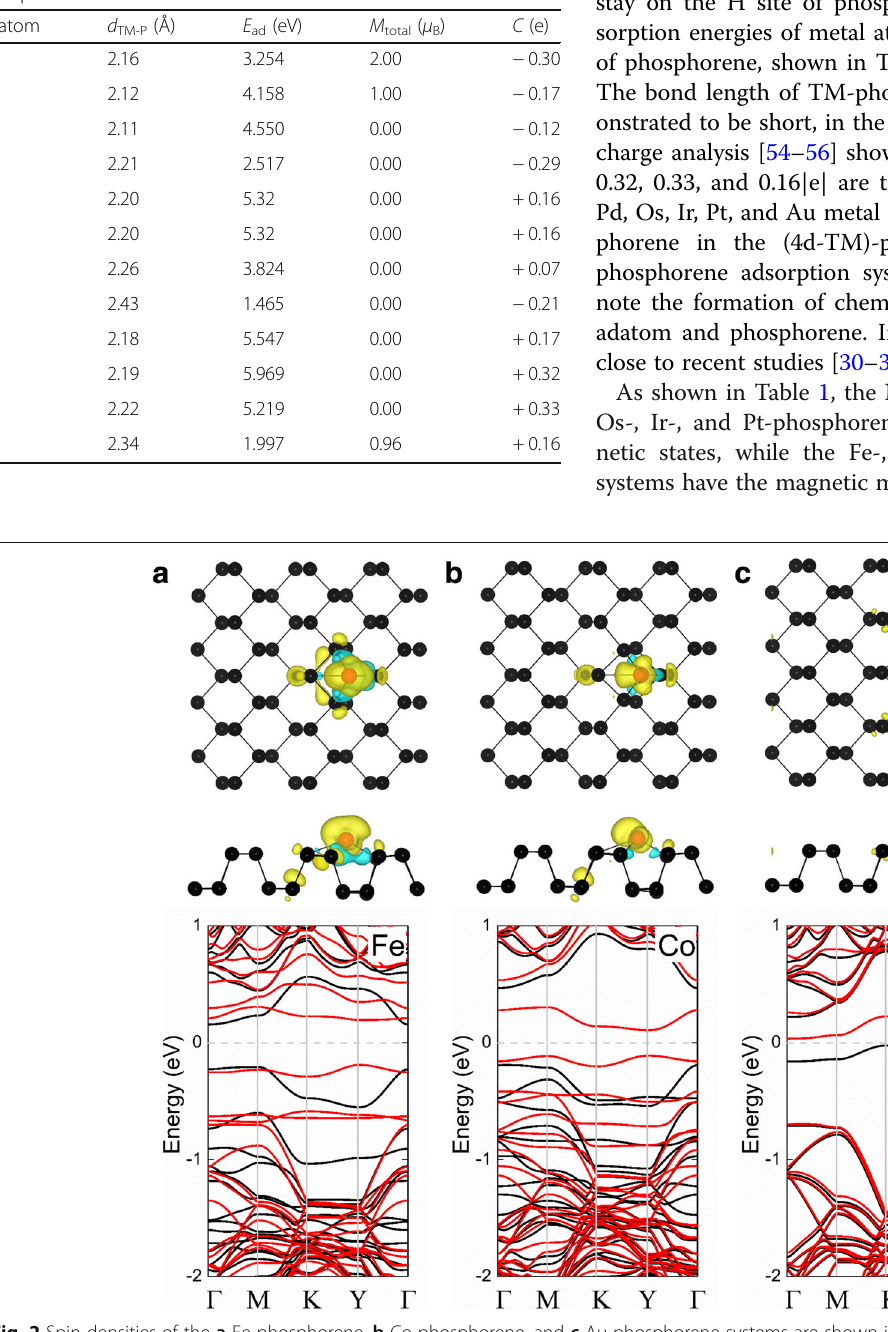
Table 1 Calculated minimum bond length of TM-phosphorene ( d TM-P ), adsorption energy ( E ad ), total magnetic moment ( M total ), and charge transferred from TM adatom to phosphorene for a single TM atom adsorbed at the most stable adsorption site on